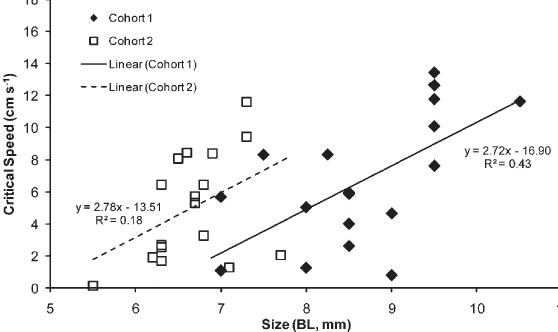
Fig . 3. – Development of critical speed in two cohorts of Gramma loreto larvae. The 95% CI for the slope of each regression line is cohort 1, 2.72±1.62, and cohort 2, 2.78±3.24. Body lengths are